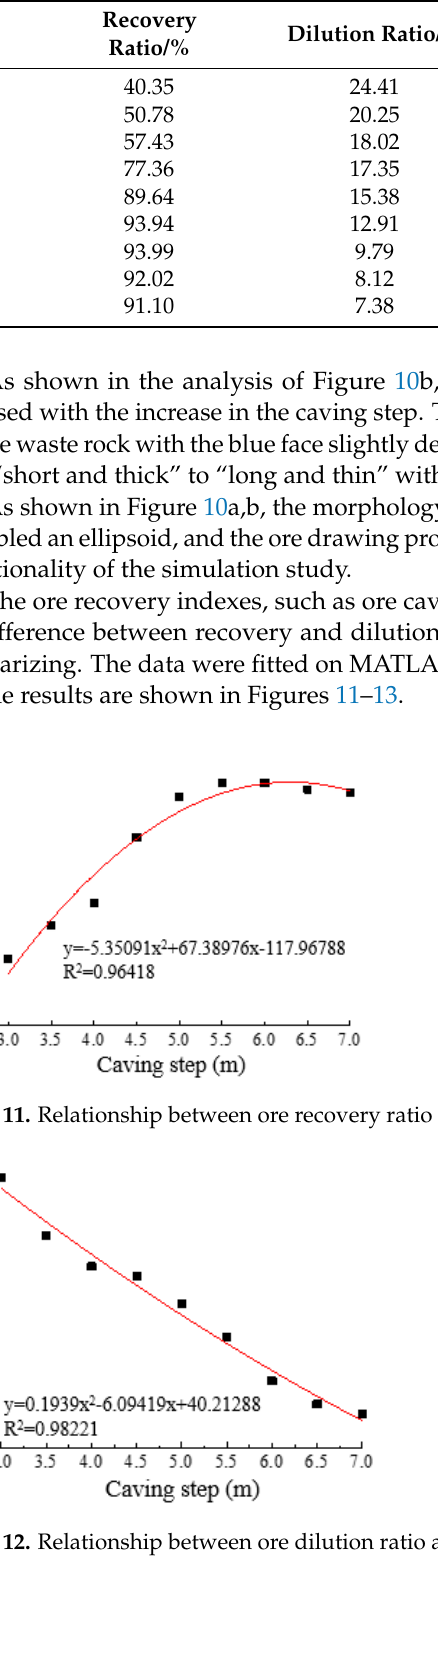
Figure 13. Relationship of the difference between recovery and dilution ratio Y and caving step. (1) Recovery ratio Figure 11 shows that the ore recovery ratio first increased and decreased with the increase in the caving step. The fitting curve results show that their relationship was quadratic, and the determination coefficient reached 0.96418. The recovery ratio was 40– 60% when the caving step was 3–4 m, indicating that a large amount of waste rock in the front was mixed into the ore to intercept the normal outflow because of the small caving step, leading to premature dilution. The ore recovery ratio reached approximately 90%